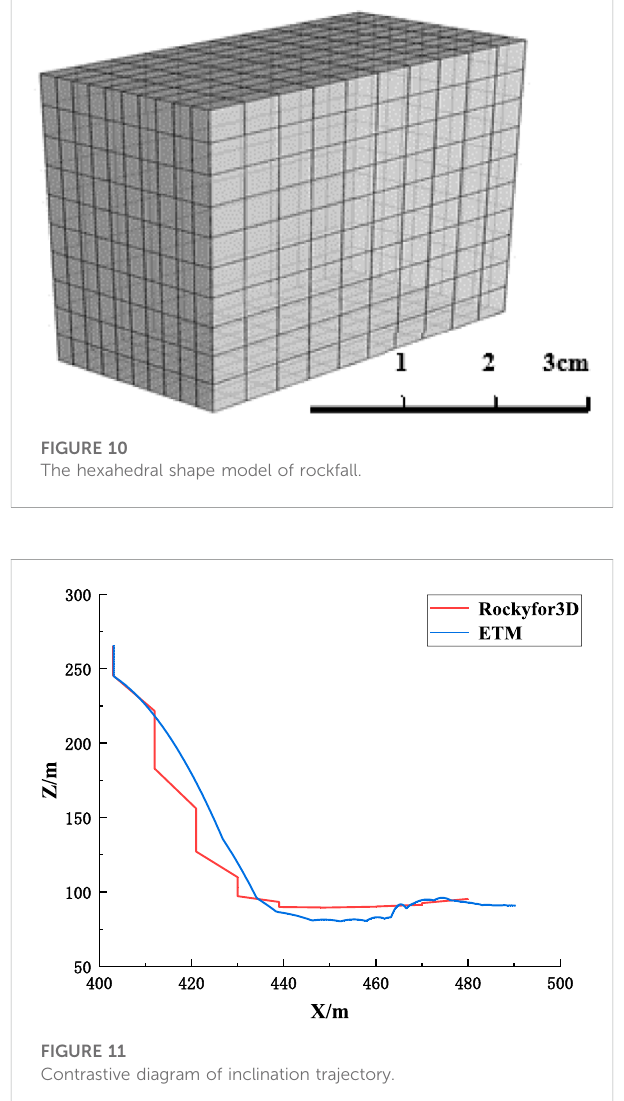
FIGURE 11 Contrastive diagram of inclination